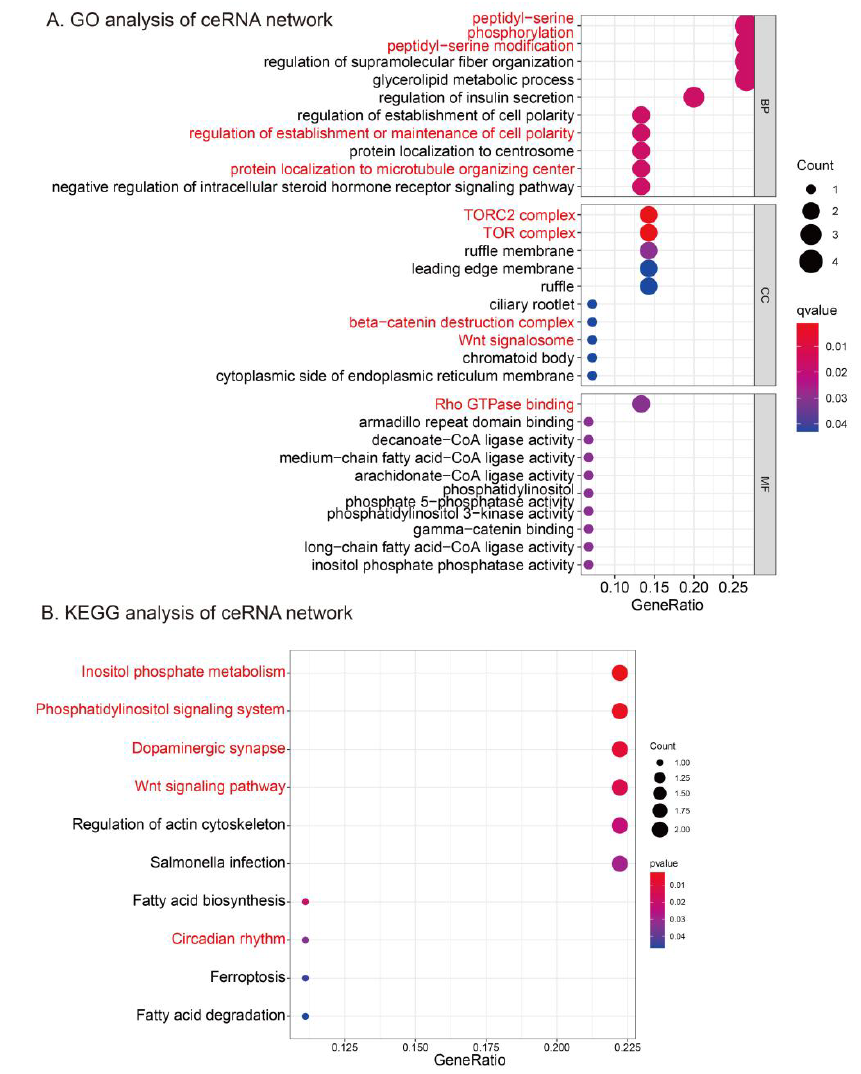
Figure 4. ( A ) GO and ( B ) KEGG enrichment analyses of the ceRNA network. Table 1. GO enrichment analysis of the ceRNA network. Table 2. KEGG enrichment analysis of the ceRNA